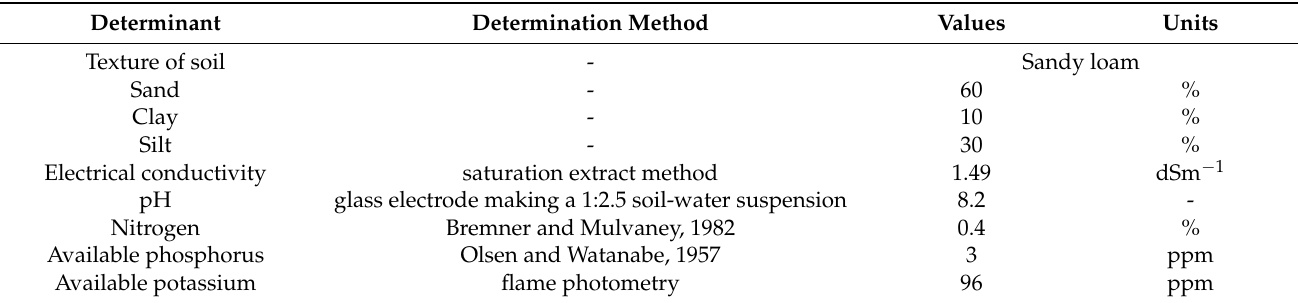
Figure 1. Meteorological data of the experimental period (Source: Adaptive Research Centre, Karor Lal Esan, Pakistan). Table 1. Physio-chemical properties of experimental soil (average over 2 years).